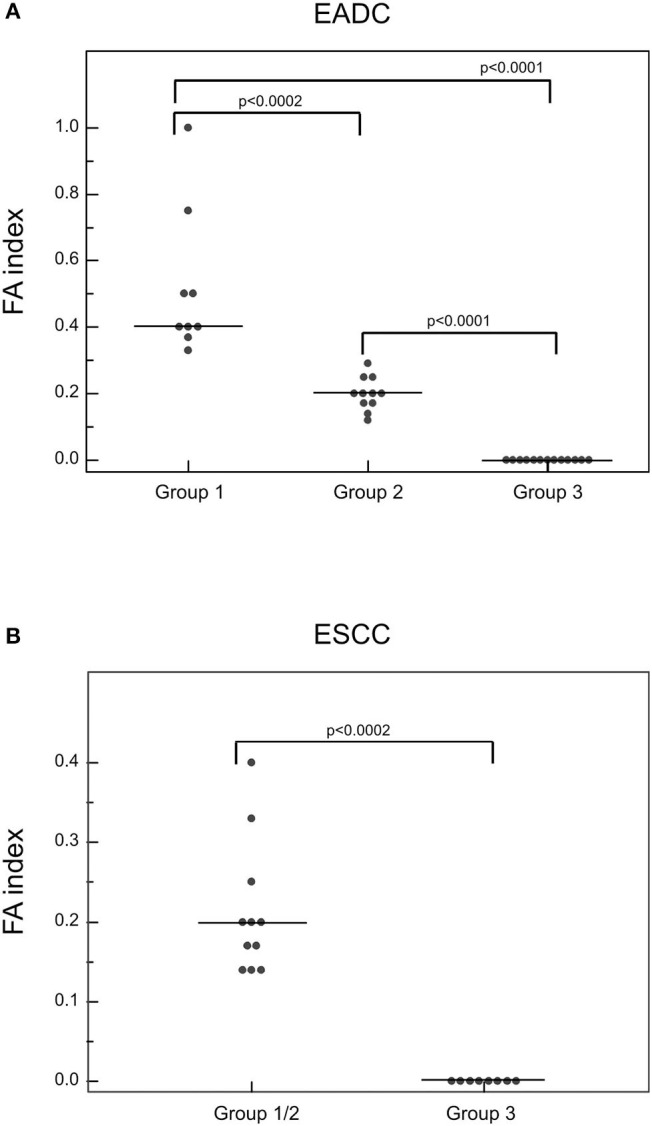
Detection of genetic alterations in cfDNA of EADC (A) and ESCC (B) patients. The plotted values correspond to the FA index obtained from dividing the number of positive markers by the total number of informative loci. P-values were calculated using the Mann-Whitney U test. Group 1 represents the highly altered profile group; group 2, the intermediate altered profile group; and group 3, the not altered profile group.